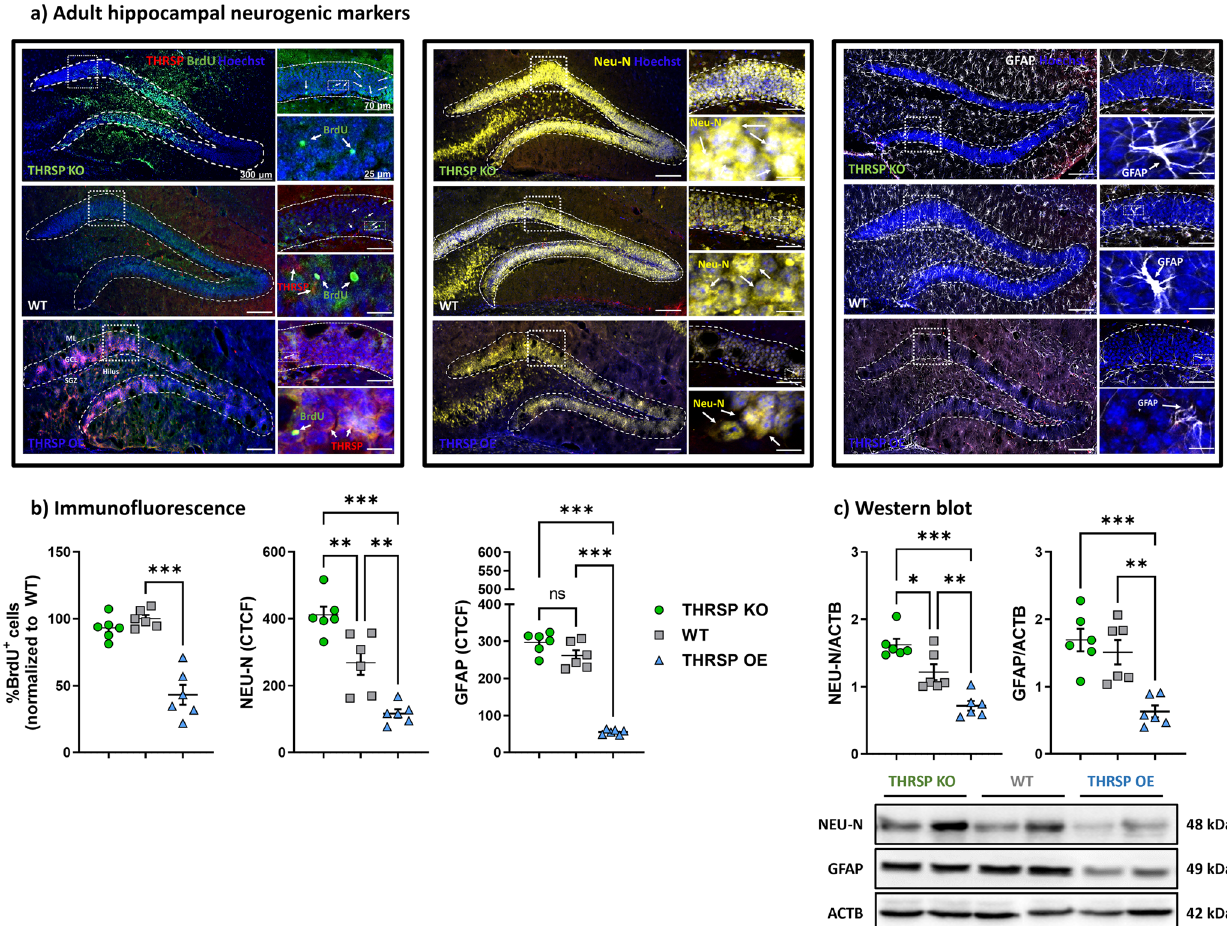
Fig. 6 Hippocampal DG immunoreactivity of BrdU, NEU-N, and GFAP. a Representative fl uorescence immunoreactivity of BrdU, NEU-N, and GFAP in mouse hippocampal DG, and their ( b ) corresponding analyses, and separate protein analyses using ( c ) western blotting. ( n = 6 mice/group; b one-way ANOVA, %BrdU + cells: F ( 2, 15 ) = 38.9, P < 0.001; NEU-N (CTCF): F ( 2, 15 ) = 32.0, P < 0.001; GFAP (CTCF): F ( 2, 15 ) = 147, P < 0.001). c One-way ANOVA, NEU-N/ACTB: F ( 2, 15 ) = 23.6, P < 0.001; GFAP/ACTB, F ( 2, 15 ) = 14.0, P < 0.001). Values are presented as the mean ± standard error of the mean